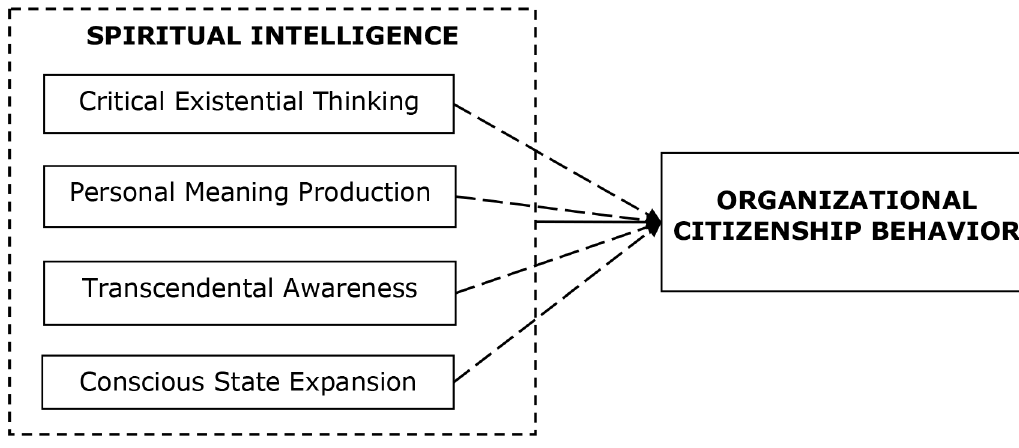
Figure 1. Conceptual Framework of the